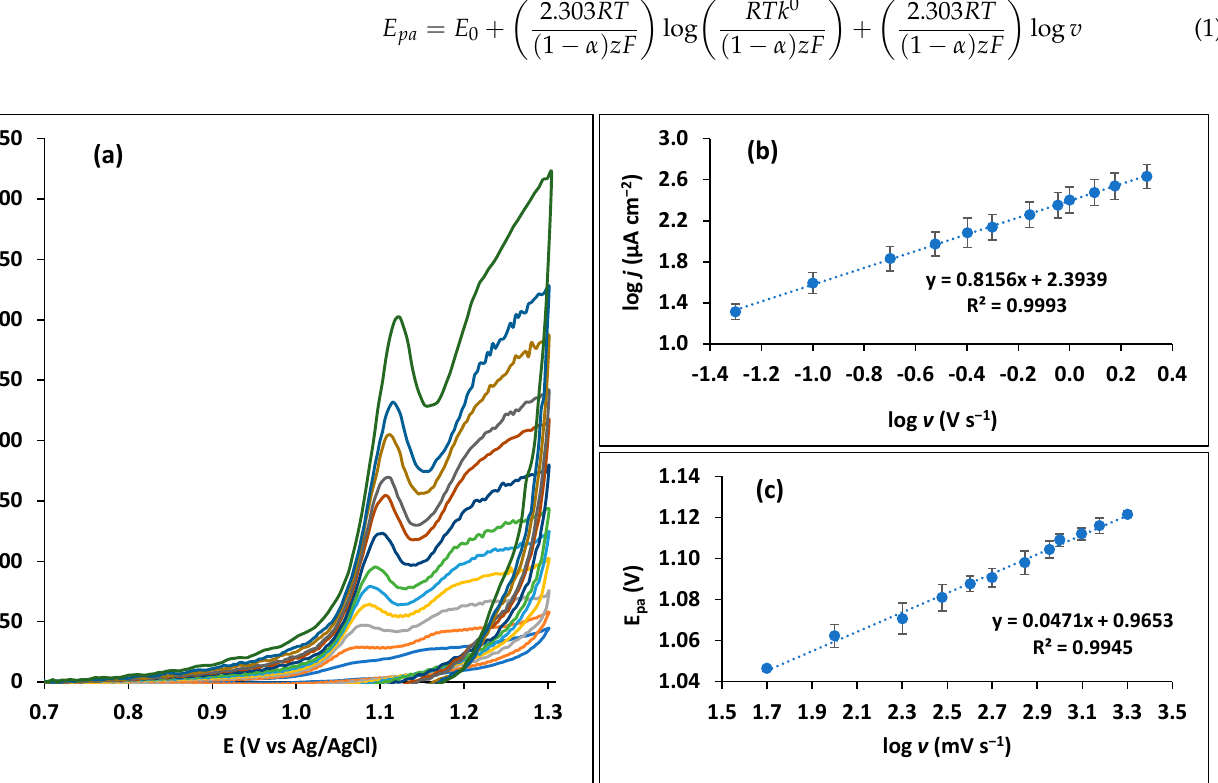
Figure 3. Scan rate study of 10 µM trimethoprim in 0.1 M Britton–Robinson buffer pH 7 on the carbon paper sensor. ( a ) Cyclic voltammograms at various scan rates (from 50 to 2000 mV s − 1 ). ( b ) Logarithm of peak current as a function of logarithm of scan rate. ( c ) Peak potential as a function of the logarithm of scan rate.